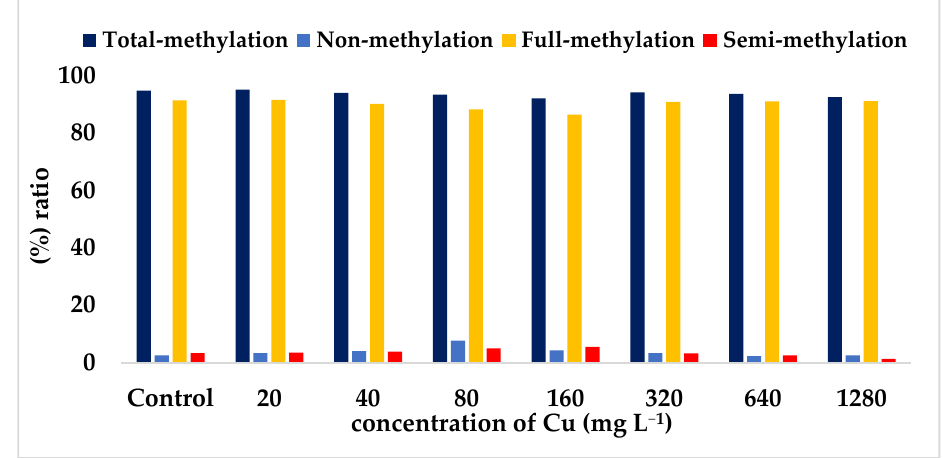
Figure 3. The average rates of methylation patterns based on CRED-RA data analysis in the root tissues of safflower seedlings after exposure to increasing Cu concentrations (20–1280 mg L − 1 CuSO 4 ·5H 2 O) for 21 days, compared to the control group (containing 0 mg L − 1 Cu and irrigated only with Hoagland solution).